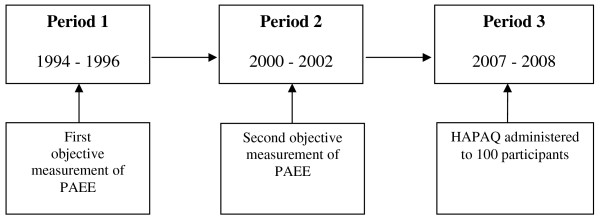
Study timeline. Objective measures of physical activity energy expenditure and delivery of HAPAQ.